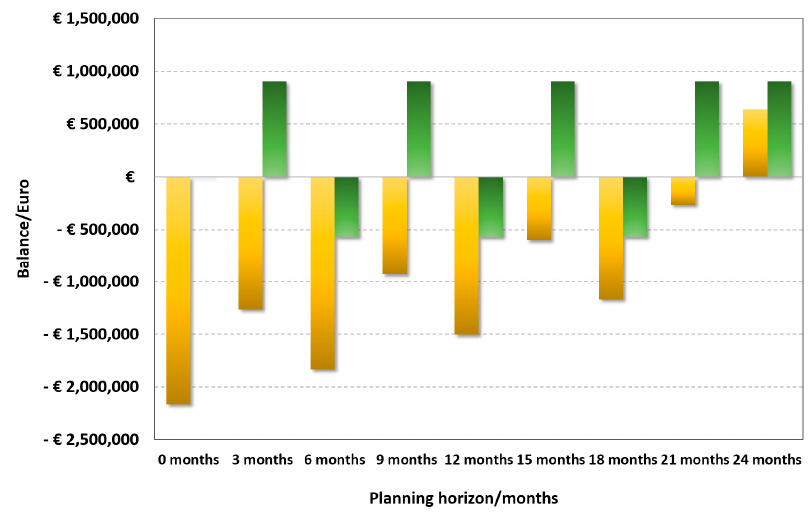
Figure 7. Economic trends of investment and profit outline for mass production of DMFC stacks (20 kUnits produced in 24 months). Yellow bars show the cash flow, green bars show the quarterly balance sheet.